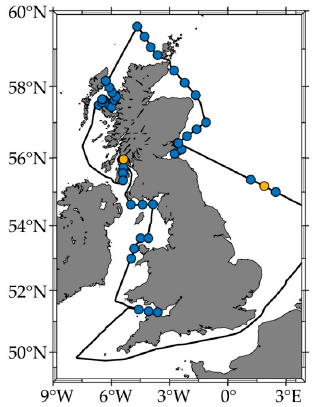
aboard R/V Heincke. Out of the 62 measurement stations visited a total of 50 complete sets of data were retrieved, matching flow cytometric data, and ancillary measurements (blue circles). Yellow circles denote stations where two samples were taken. The figure was adapted and modified with permission from Figure 1 of Agagliate et al. [2].